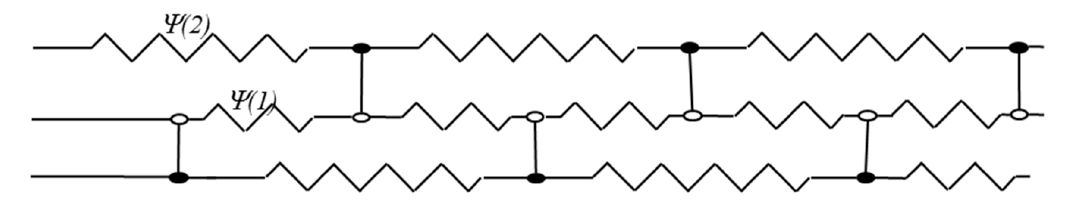
Figure 17. The one-dimensional model of discrete microstructure.